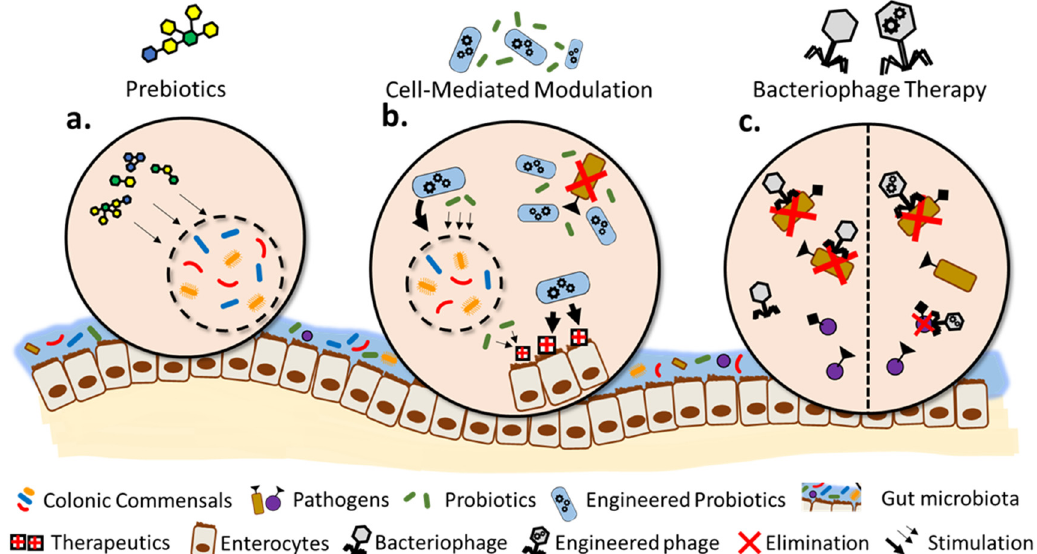
Figure 1. Overview of targeted methods to manipulate the gut microbiome. ( a ) Administration of targeted prebiotics to stimulate the growth of beneficial microbes; ( b ) use of targeted probiotics and engineered probiotics to eliminate pathogens or directly change the functional output of the gut microbiome; and ( c ) use of bacteriophages to eliminate specific species of pathogens or target pathogens with certain genes.